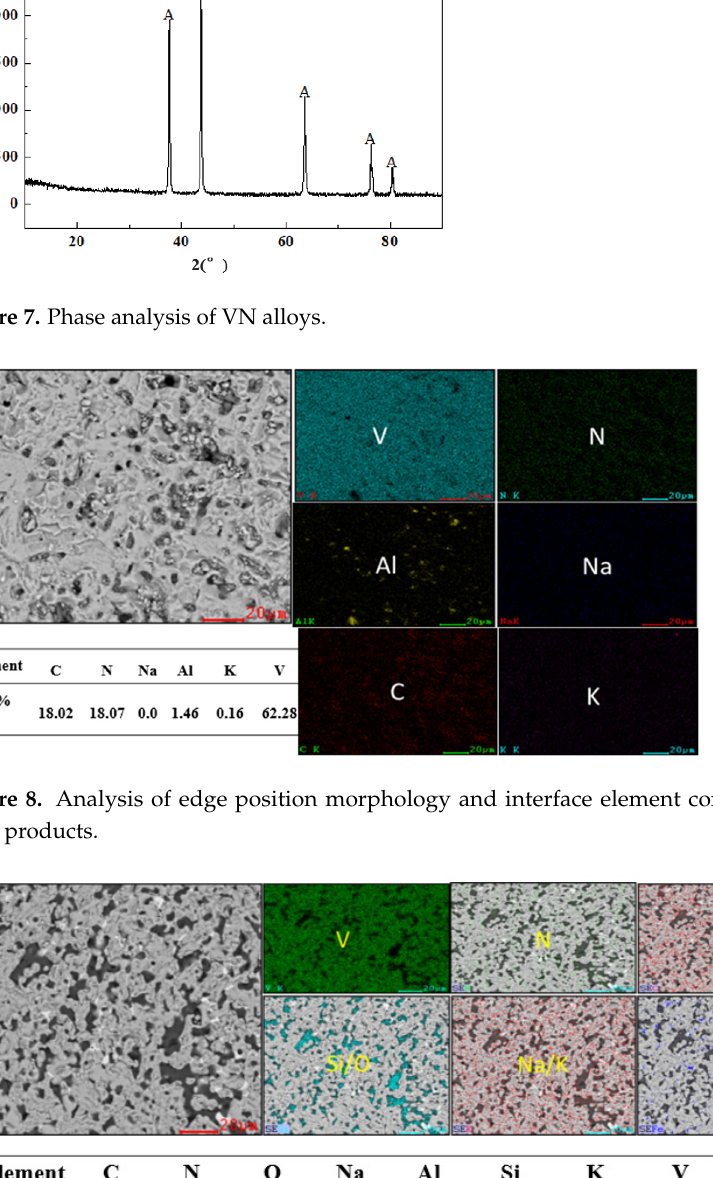
Figure 7. Phase analysis of VN alloys.